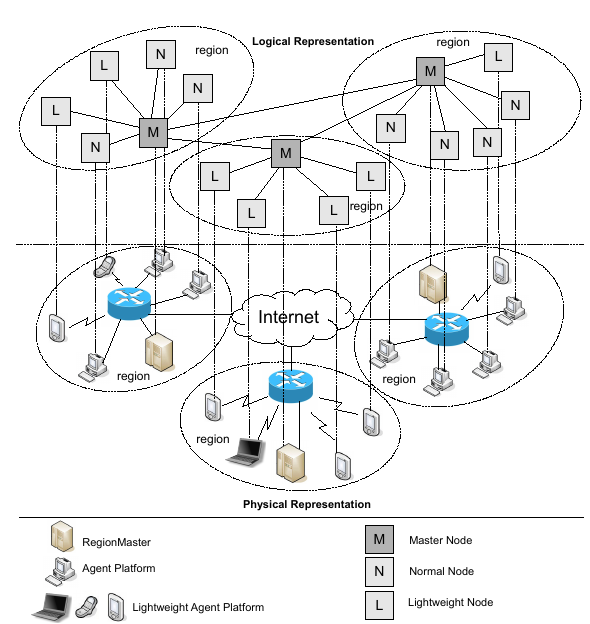
Figure 2. SpeedUp communication infrastructure